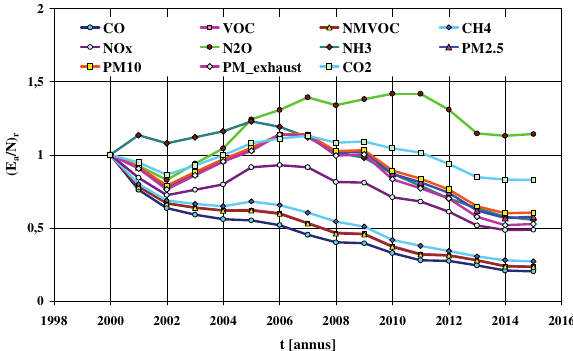
Fig. 20. Relative national annual emission of individual pollutants from one conventional motor